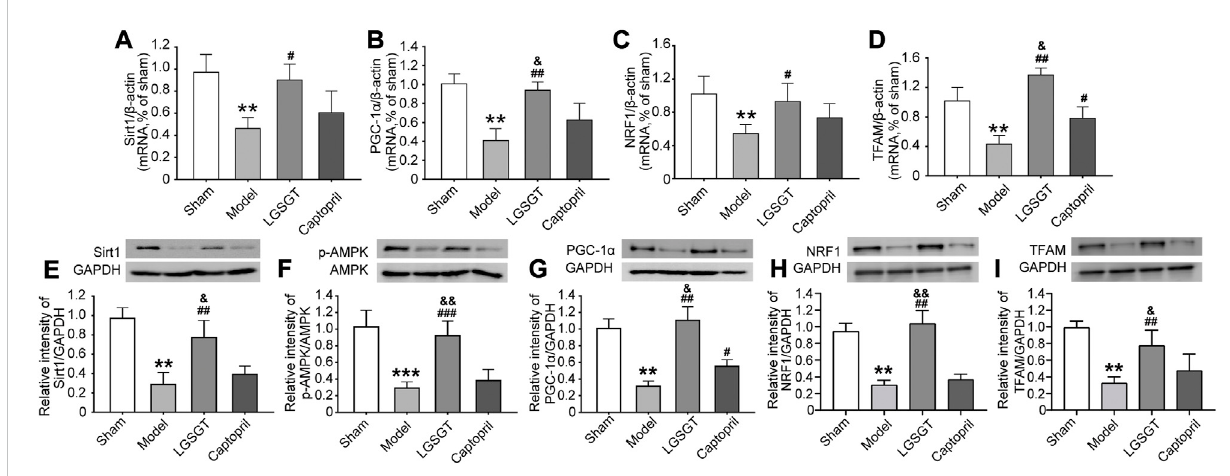
Linggui Zhugan Decoction played a protective role through the SIRT1-AMPK-PGC-1 α pathway. (A – D) RT-PCR was used to detect the expression levels of theSIRT1-AMPK-PGC-1 α pathway and downstream NRF1 and TFAMmRNA in the myocardial tissue of rats with heart failure after treatment with Linggui Zhugan Decoction ( n = 6). (E – I) Western blot was used to detect the expressions of SIRT1, p-AMPK, PGC-1 α , NRF1, and TFAM proteins in the myocardial tissue of rats with heart failure after treatment with Linggui Zhugan Decoction ( n = 3). * p < 0.05 vs. sham group; ** p < 0.01 vs.